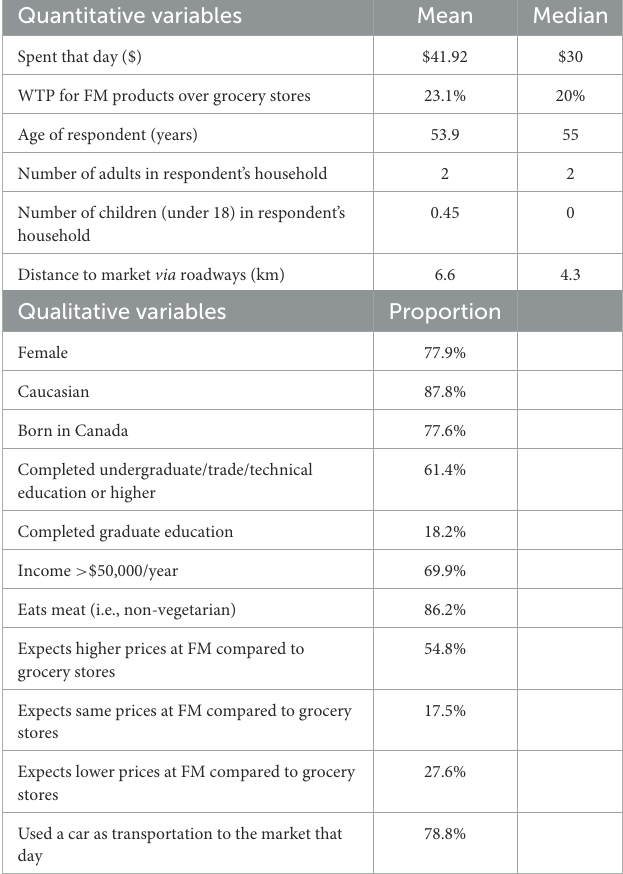
TABLE 2 Summary statistics of respondents, n =